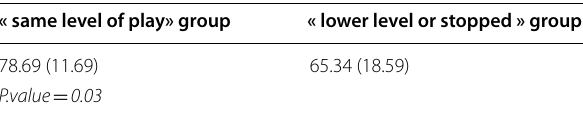
Table 3 Mean score of the SIRSI group who returned to sport vs